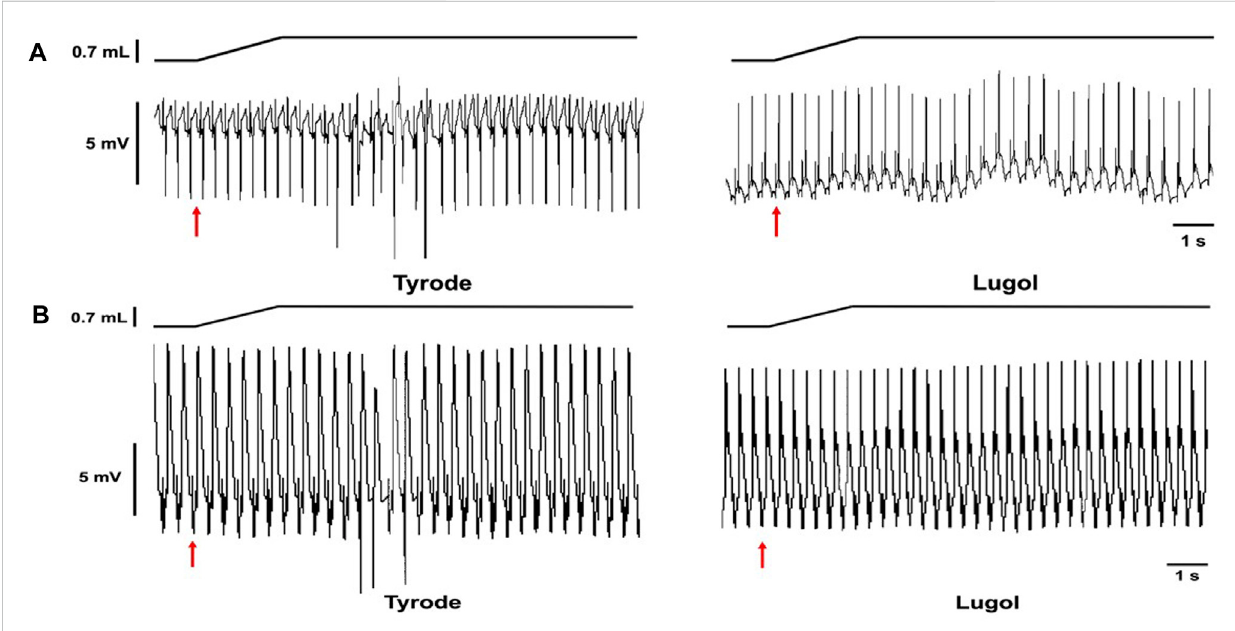
FIGURE 1 Stretch-inducedectopicsare attenuated byLugol. Records from2Langendorffperfused rabbitheartsinsinus rhythm (A,B) . Schematic ofchangein balloonvolume(uppertraces)andpseudo-ECG(lowertraces).Theredarrowsindicatesthestartofaleftventricular(LV)indwellingballoonin fl ationfrom 0.2 mL to 0.9 mL to dilate/stretch the LV. Records prior to Lugol treatment (left, Tyrode) and following LV lumen irrigation with 0.5 mL Lugol, over a 10 s period,followedbyTyrodeirrigation(right,Lugol).Inbothhearts,priortoLugol,dilationprovokedmechanically-activatedectopics;followingLugol these ectopics were abolished.